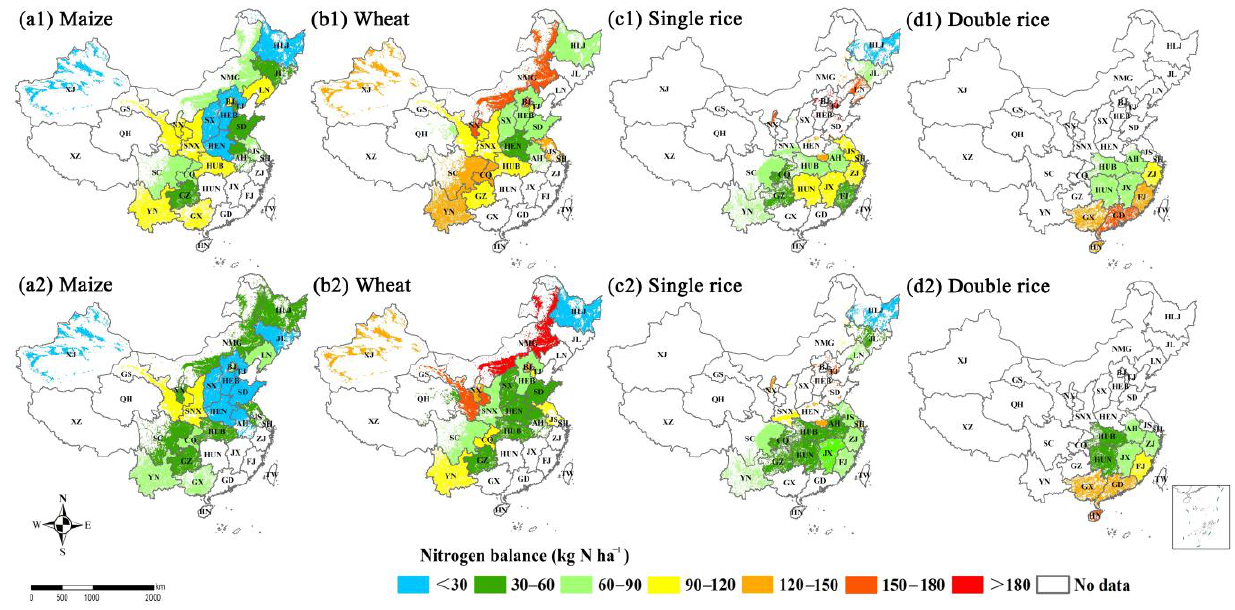
Figure 3. Nitrogen balance (NB) per hectare (kg N ha −1 ) after harvest between 2004 – 2008 and 2014 – 2018 for ( a1 , a2 ) maize, ( b1 , b2 ) wheat, ( c1 , c2 ) single rice and ( d1 , d2 ) double rice at provincial scale in China’s farmlands, respectively.